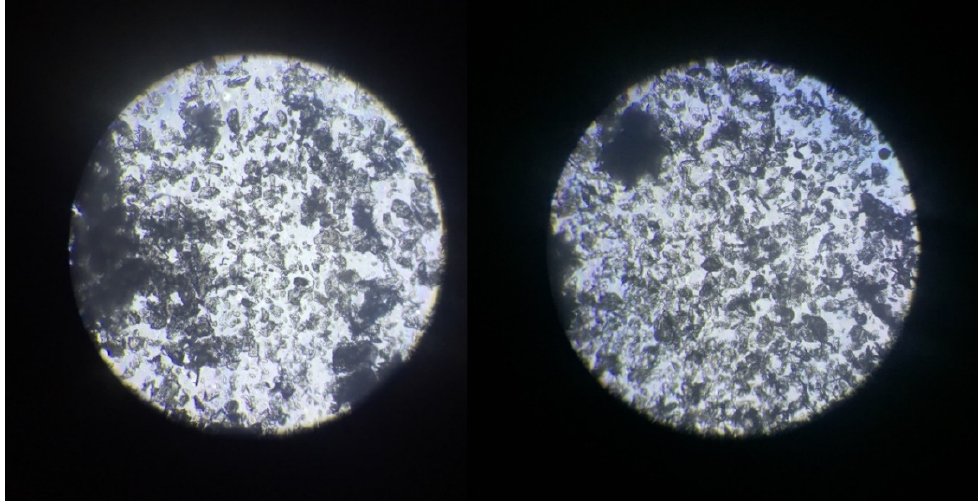
Figure 8. The amounts of talc powder forming a uniform layer on the spherical electrode (as in Figure 5), seen at 100× magnification (PZO Poland microscope).